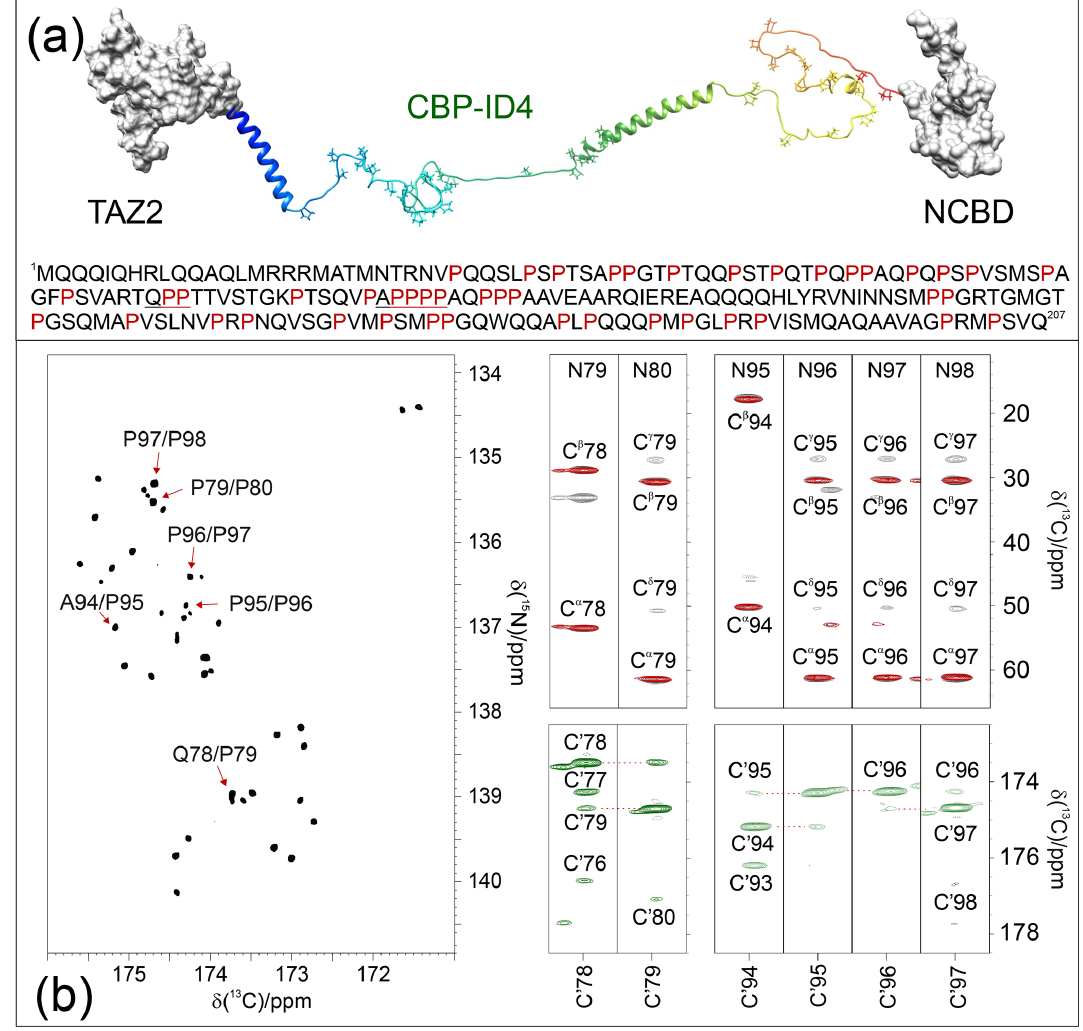
Figure 4. The case of CBP-ID4 (residues 1851–2057 of human CBP). (a) One of the possible conformations of the CBP-ID4 fragment (blue to red ribbons) and the two flanking domains, TAZ2 and NCBD, clearly demonstrate that, in this region of CBP, the intrinsically disordered part is highly prevalent with respect to ordered ones. The amino acid sequence of CBP-ID4 is also reported. (b) The 2D CON Pro spectrum shown on the left, which, at first sight, could seem like a 2D spectrum of a small globular protein, reports the proline fingerprint of this complex IDR. Several strips extracted from the 3D (H)CBCACON Pro (grey contours), 3D (H)CCCON Pro (red contours), and 3D (HCA)COCON Pro (green contours) are shown to illustrate the information available for the sequence-specific resonance assignment of this proline-rich fragment of